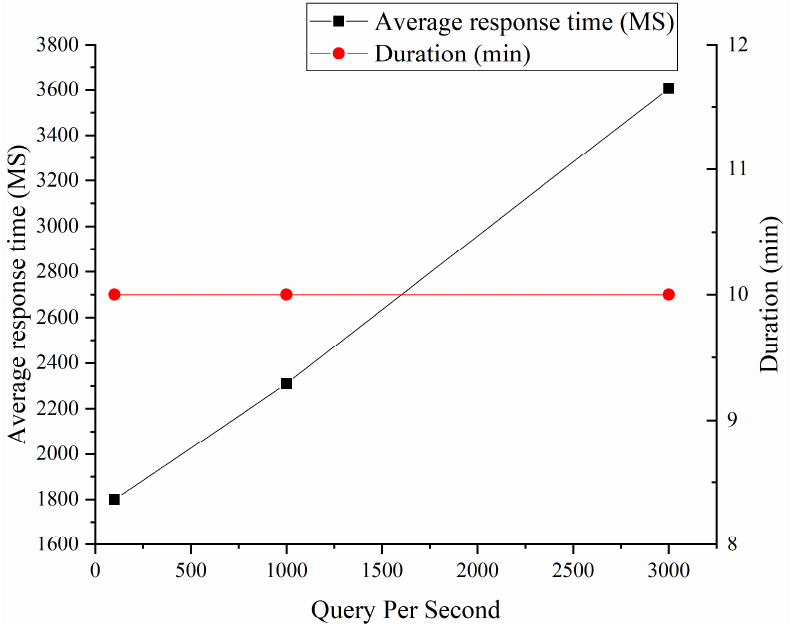
Figure 8. Test of stress (drawn according to the test results after research and design combined with data).